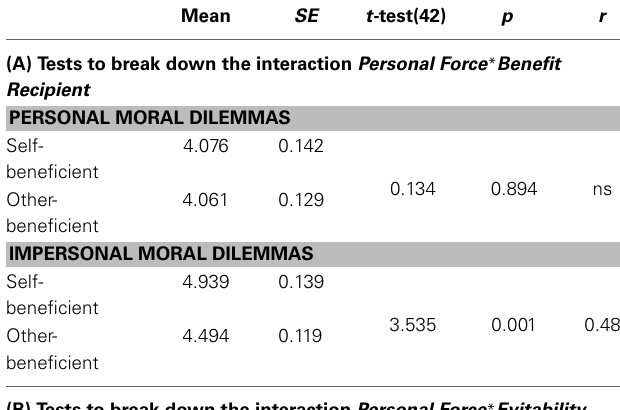
Table 7 | Follow-up t -tests to break down the interactions in the moral judgment